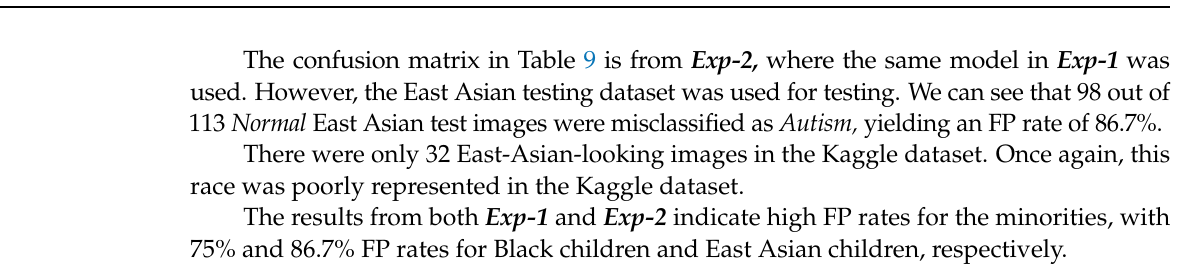
Table 9. Confusion matrix from Exp-2 (model trained with the Kaggle dataset but tested against the East Asian test dataset).